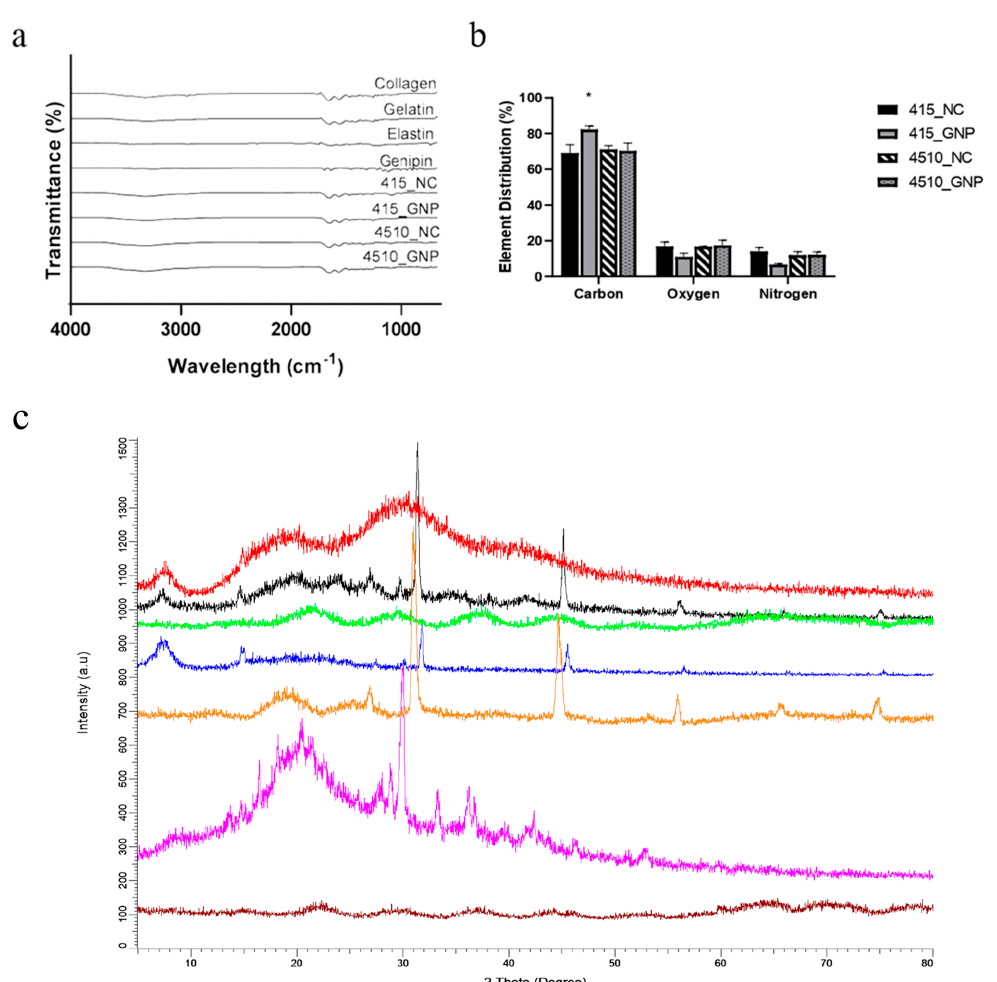
Figure 3. Effect of cross-linking on the chemical and thermal properties of CollaGee biomaterials. ( a ) Fourier-transform infrared spectroscopy (FTIR) analysis to identify chemical structure of CollaGee biomaterials. Results indicated that both 415_GNP and 4510_GNP had no change of chemical structure after cross-linking. ( b ) Energy-dispersive x-ray (EDX) analysis revealed the carbon element was dominant in both cross-linked and non-cross-linked groups, followed by oxygen and nitrogen. Carbon in 415_GNP was significantly higher than in the three remaining groups; * p < 0.05. ( c ) X-ray diffraction (XRD) analysis to determine the crystallinity of CollaGee biomaterials. Results indicated that both cross-linked and non-cross-linked groups were amorphous. The spectra from above downwards; 415_GNP, 415_NC, 4510_GNP, 4510_NC, collagen type I, gelatin, and elastin.